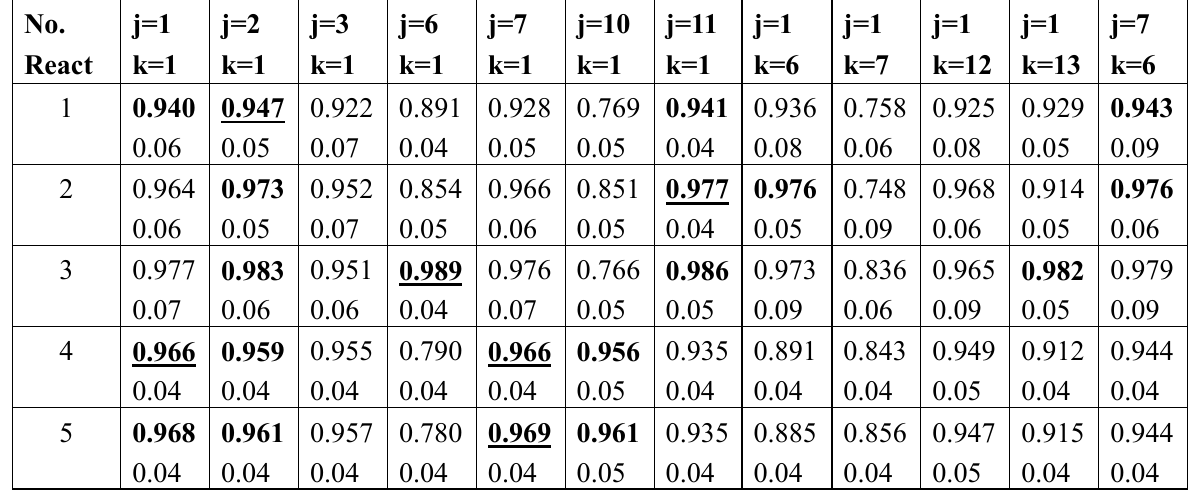
/nm (lower) obtained from the r vs. R c